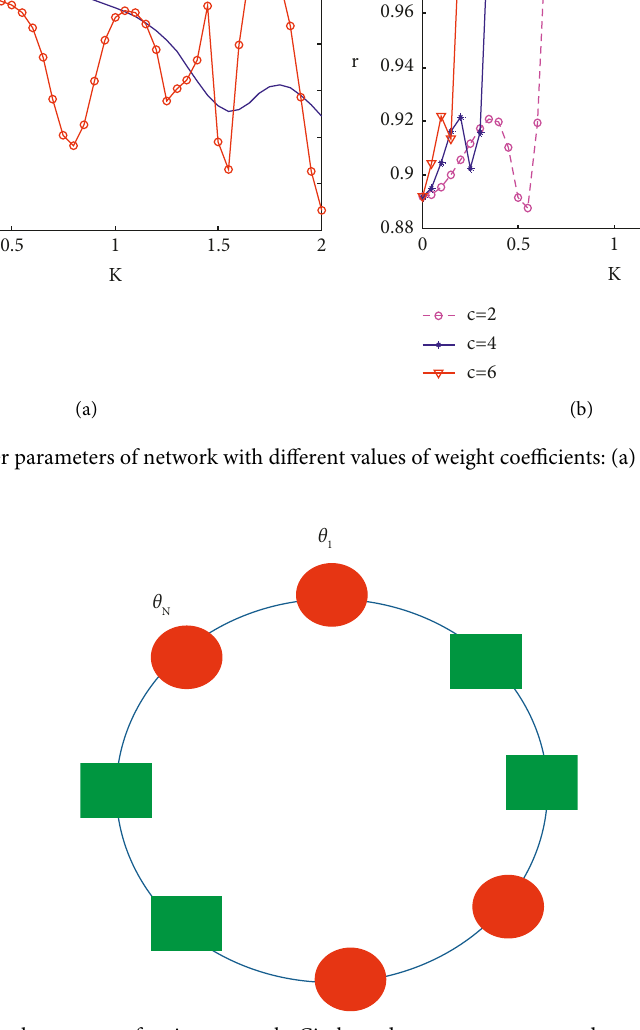
Figure 4: The topological structure of a ring network. Circle nodes are generators, and square nodes are